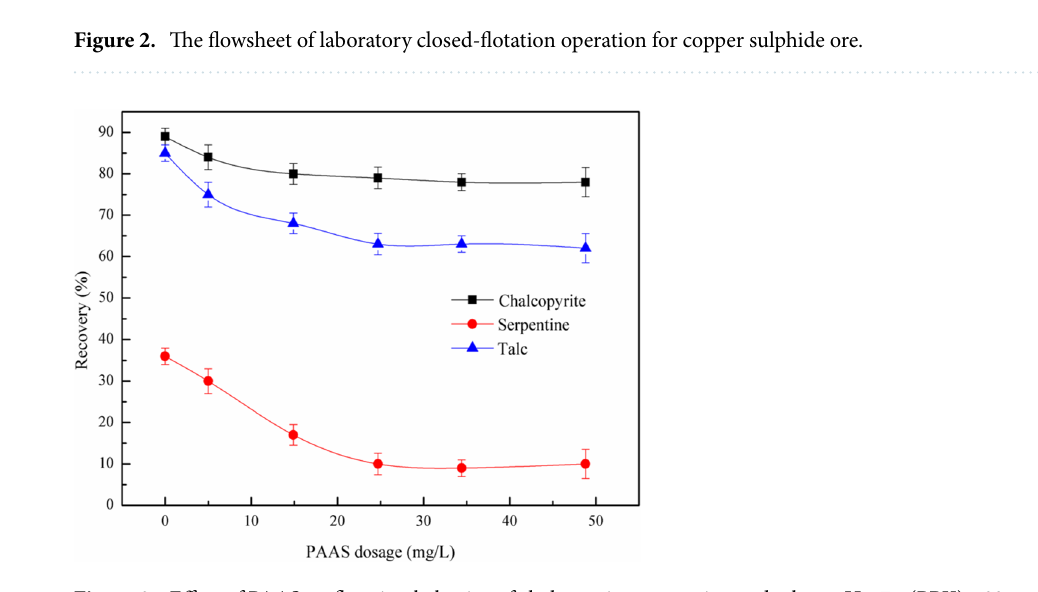
Figure 3. Effect of PAAS on flotation behavior of chalcopyrite, serpentine and talc at pH = 7, c (PBX) = 80